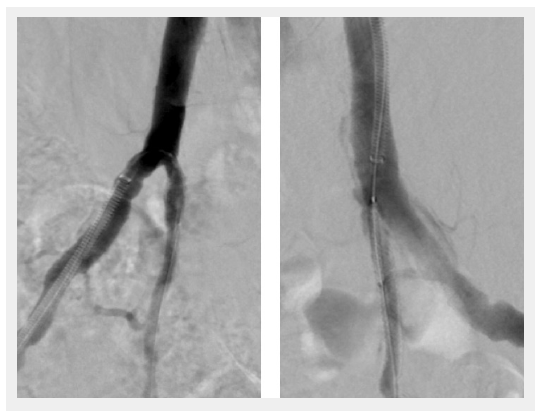
Angiographic result after bilateral placement of drug eluting